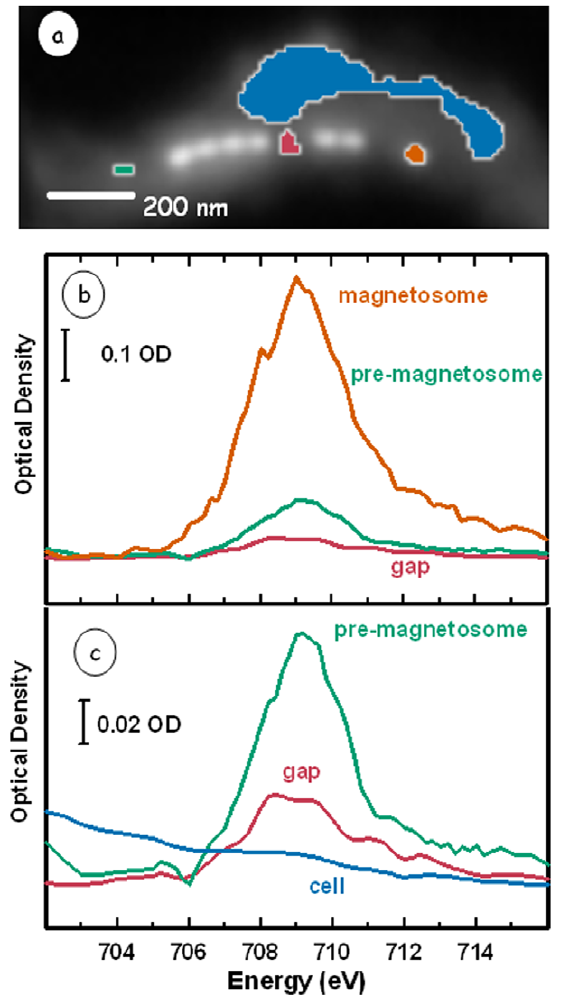
Figure 3. STXM image at 709.8 eV of an MV-1 cell with two gaps along the magnetosome chain. (b) Fe 2p 3/2 spectra (average of left and right circular polarization data) of different regions of the cell: a single magnetosome (red), the first gap (pink), the ‘‘pre- magnetosome’’ (green), and the cytoplasm of the cell (blue) away from the magnetosome chain. (c) Expansion of the gap and pre-magneto- some spectra. The vertical lines indicate energies traditionally associated with Fe(II) and Fe(III) oxidation state signals.